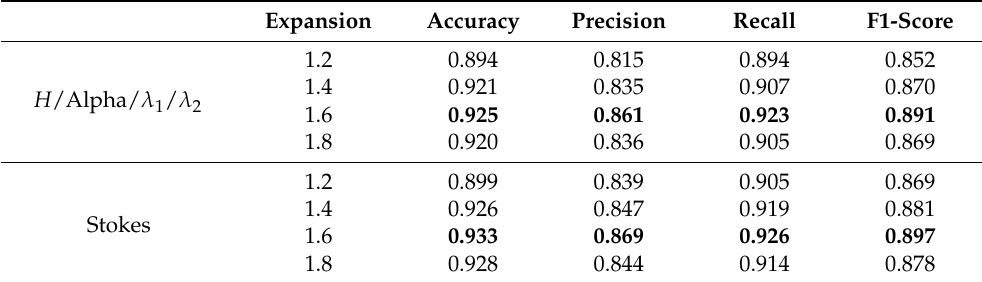
Table 12. Indicators of Polarized parameters with 125 × 125 superpixels and different expansion